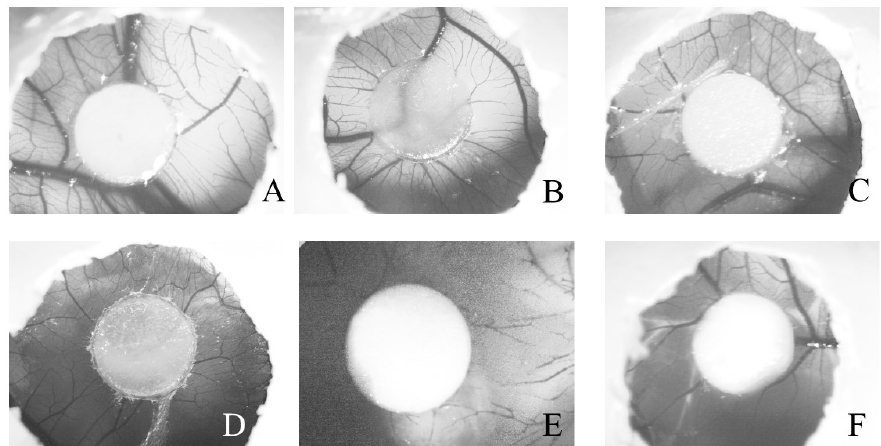
Figure 6. Photomicrograph of different chick embryo chorioallantoic membranes (CAM) after 72 h of treatments with ( A ), oEd 146 (oEd 146 µg/disk); ( B ), 292 (oEd 292 µg/disk); ( C ), oEd 584 (oEd 584 µg/disk); and ( D ), olive oil (20 µL, negative control); ( E ), DEXA (dexamethasone 80 µg/disk, angiogenesis inhibitor) and ( F ) RG (Regederm ® 20 mg/disk, angiogenesis inductor). Evaluation of CAMs showed a proangiogenic response by macroscopic semiquantitative scoring. The images illustrate representative examples of different responses (score rangeaccording to Ribatti, D, et al. 2006 [40]), as observed under an Axiovert Light Microscope with the aid of the AxioVision 100 software (both Zeiss, Göttingen, Germany), at the magnification of 0.5 × 1.25.